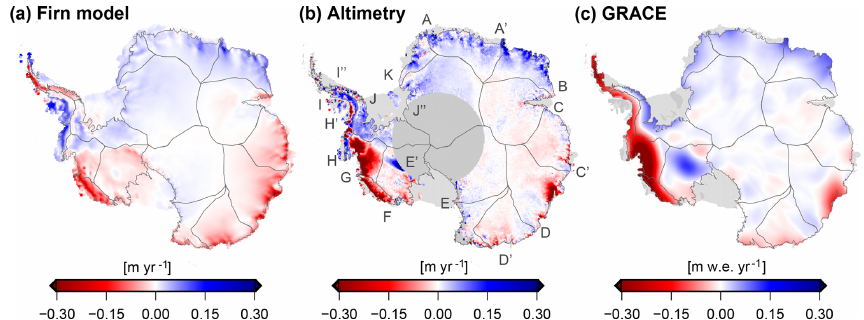
Figure 14. Mean rates for the time interval 2002–2016 of elevation changes from IMAU-FDM (a) , from the multi-mission SEC grids (b) and of the mass changes from GRACE (c)